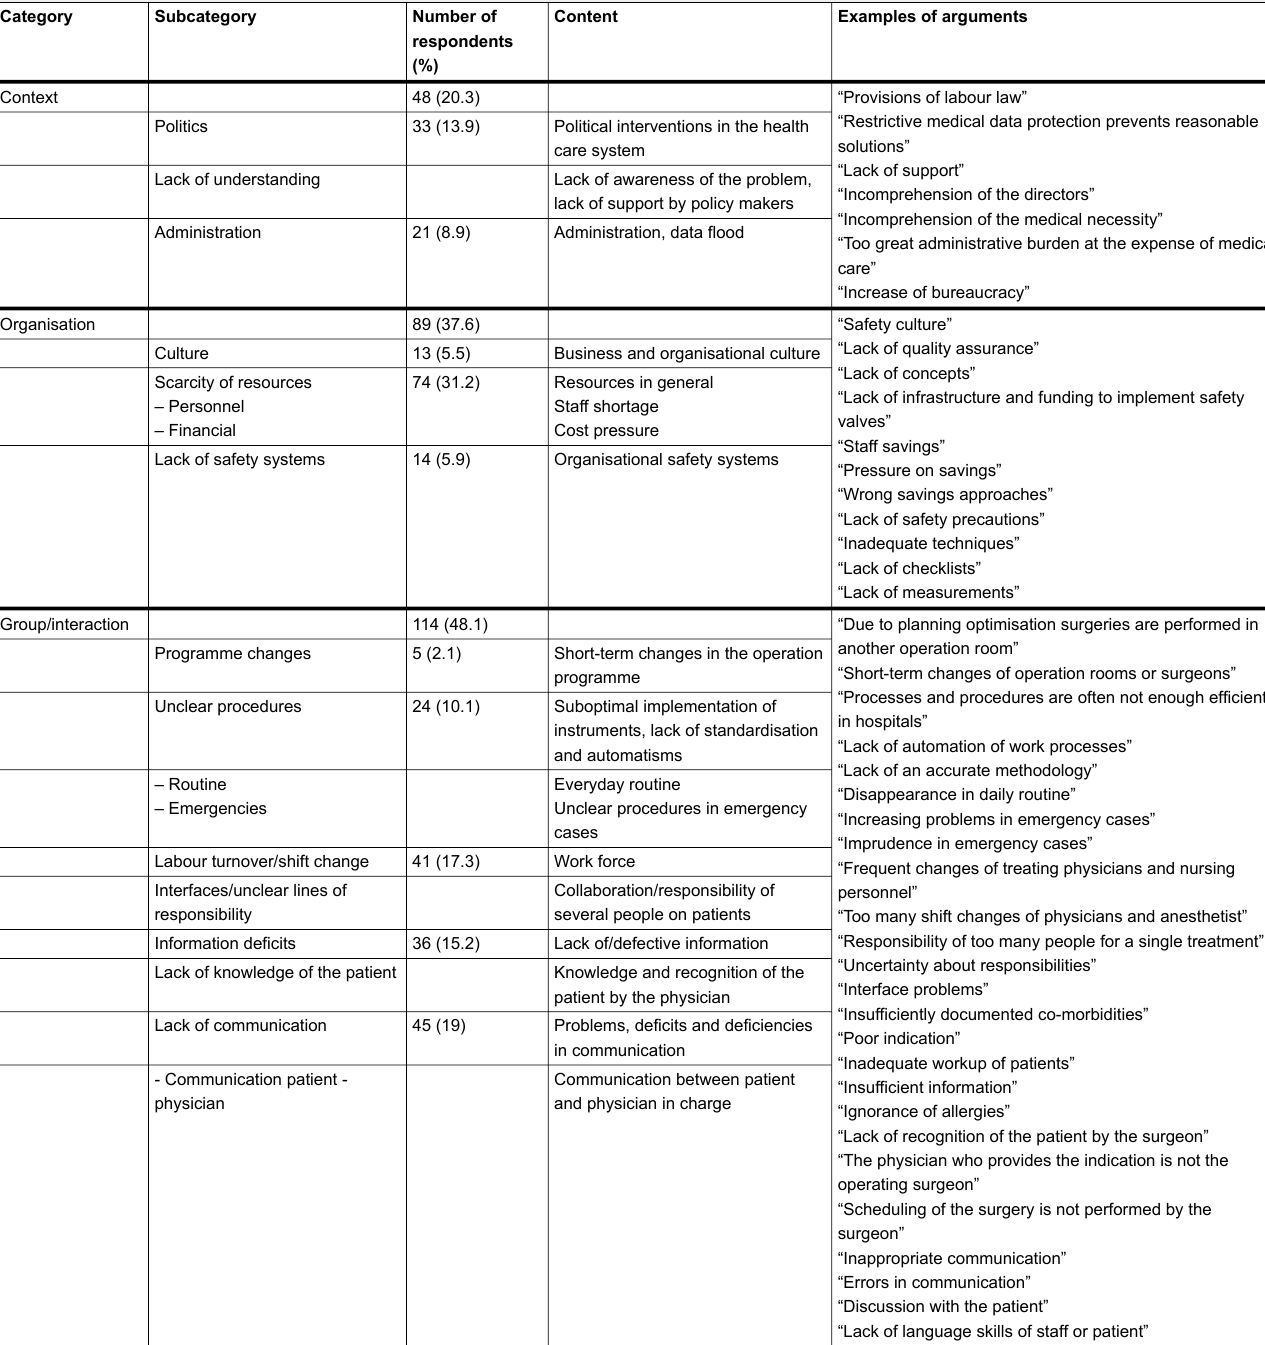
Table 2: Examples of reasons for the persistence of potential adverse events despite the efforts to improve patient safety in Switzerland and the number of respondents per main category and combined subcategory (n = 237).